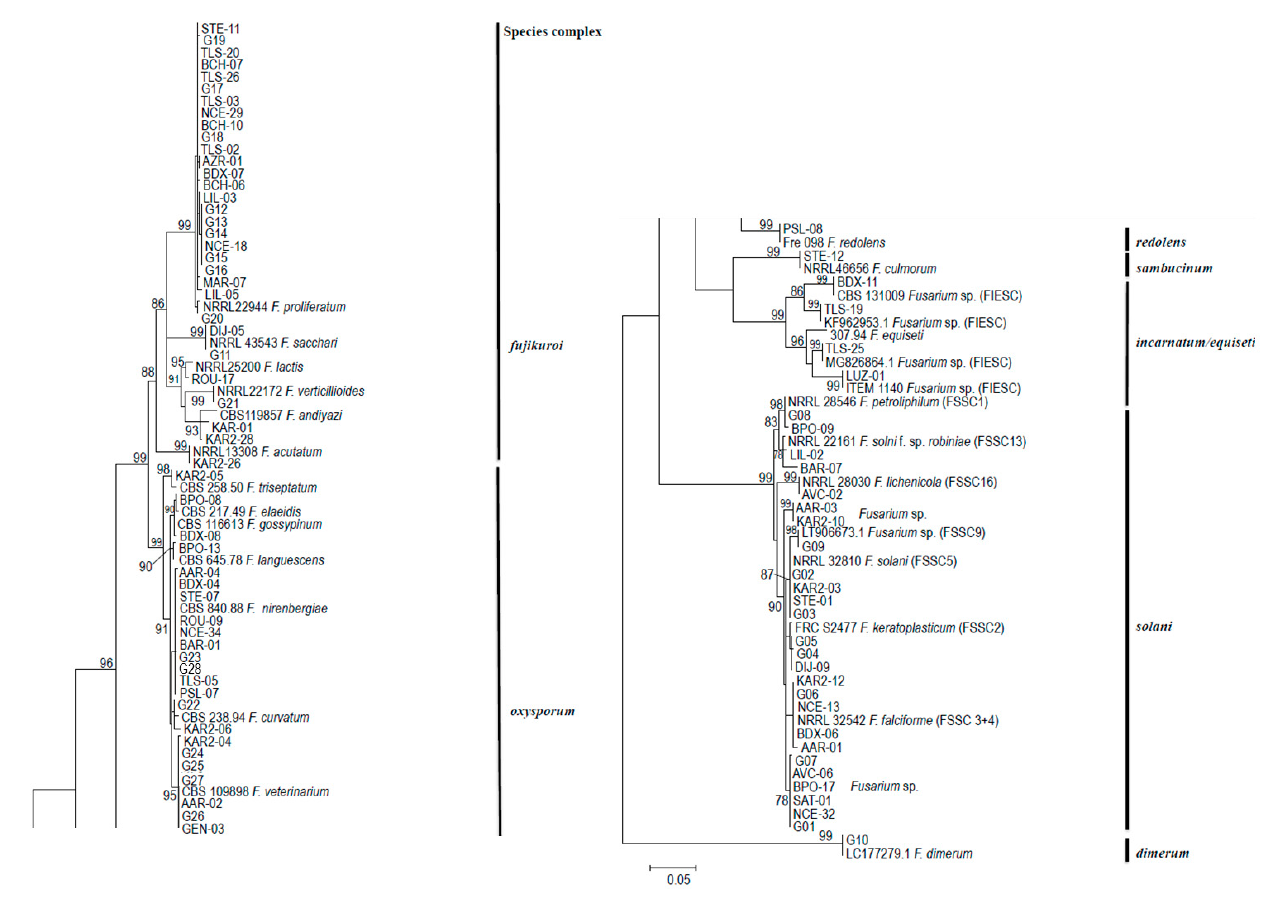
Figure 2. Distribution of 86 different sequences of TEF1 α from 182 Fusarium spp. isolates collected in 20 European centers during a one-year prospective study compared to reference sequences.